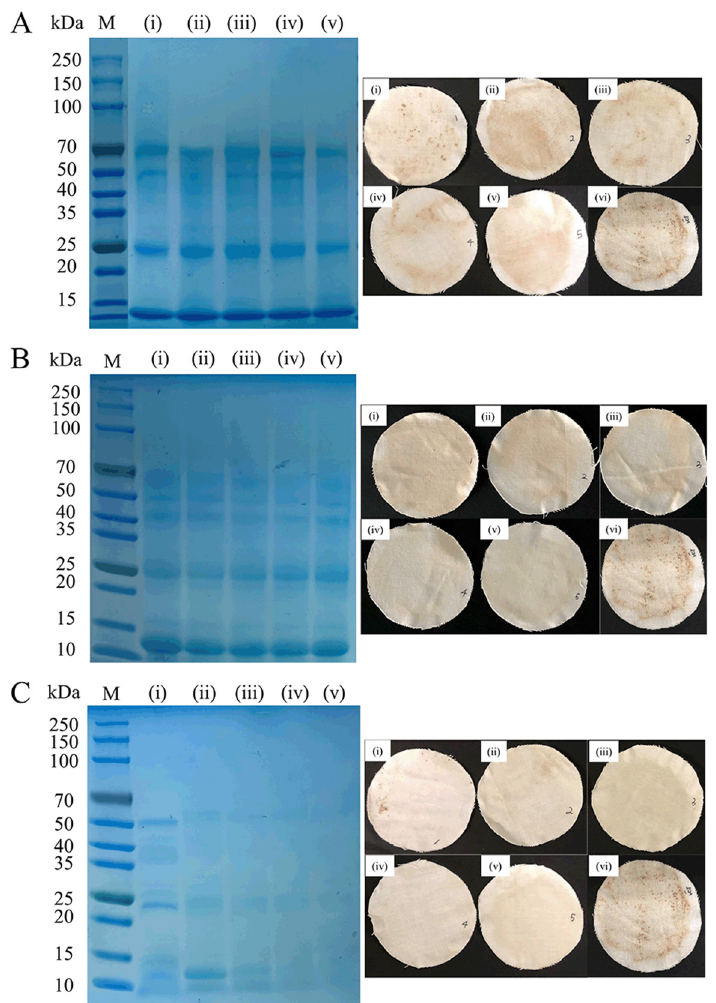
Figure 5. Deposition effect after the blood is decomposed by proteases. ( A ) Alkaline protease. ( B ) Keratinase. ( C ) Trypsin. (i) Reaction 10 min. (ii) Reaction decomposition 20 min. (iii) Reaction 30 min. (iv) Reaction 40 min. (v) Reaction 50 min. (vi) No added